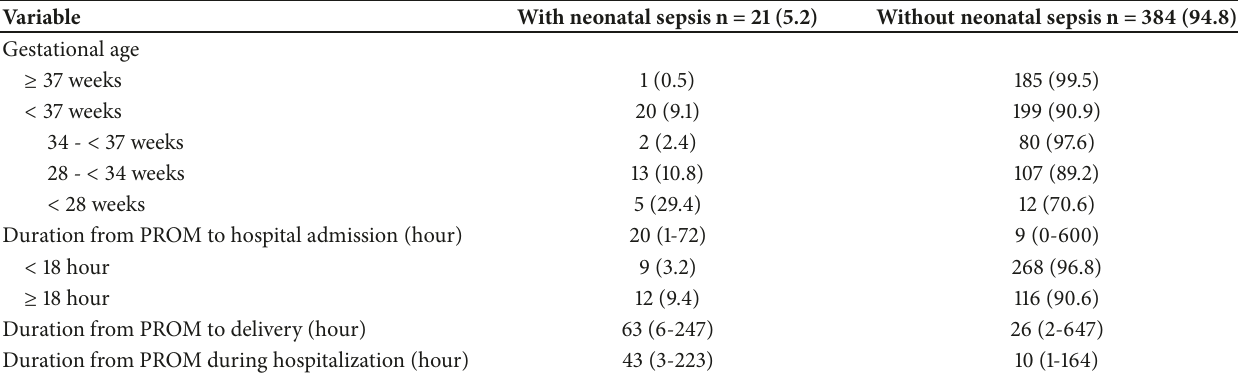
Table 2: Distribution of risk factors based on incidence of neonatal sepsis.